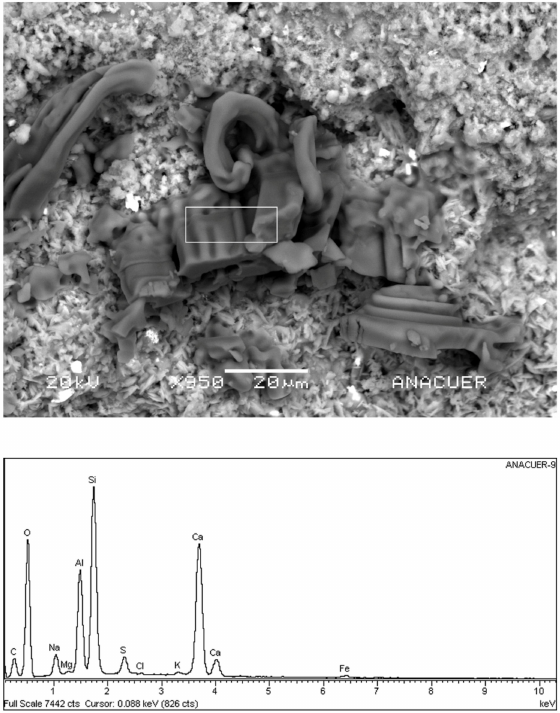
Figure 7. Efflorescence and their elemental composition found in a sample of